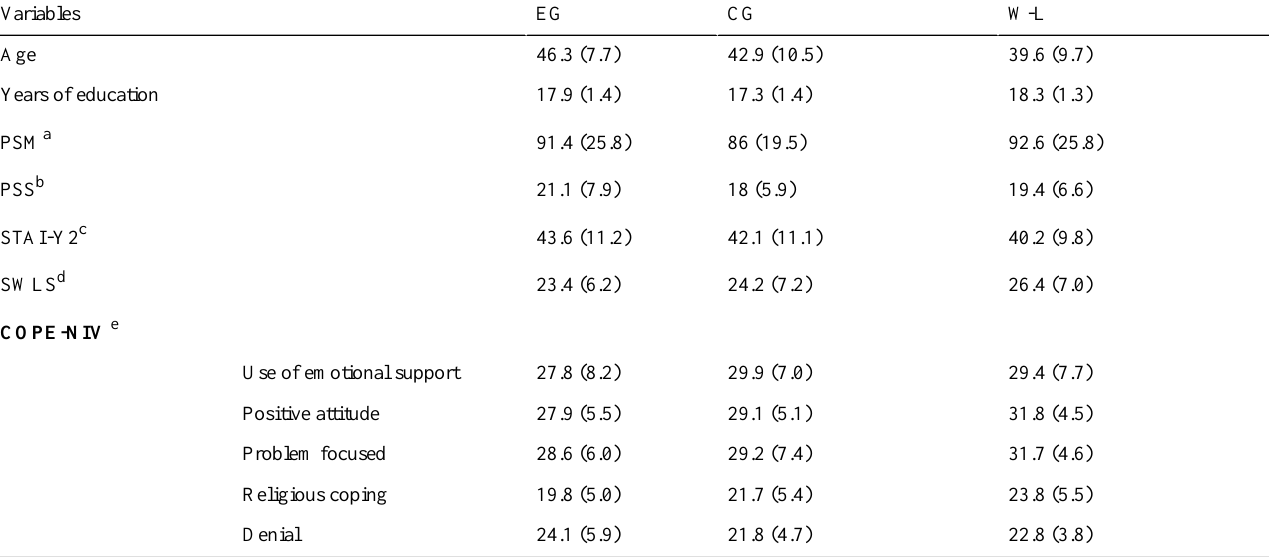
Table 1. Demographic parameters and baseline characteristics of the sample (mean and standard deviation).